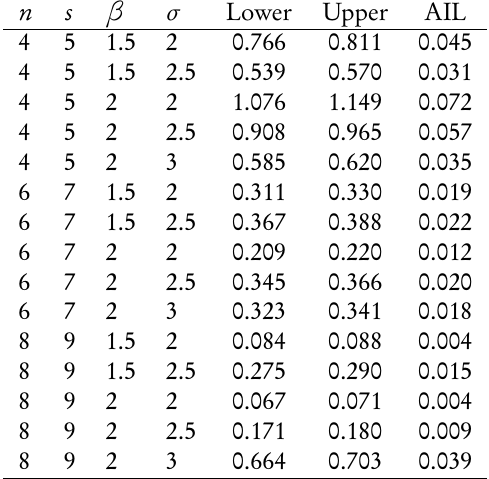
The lower and upper bound for st h record and AIL for k = 2 .